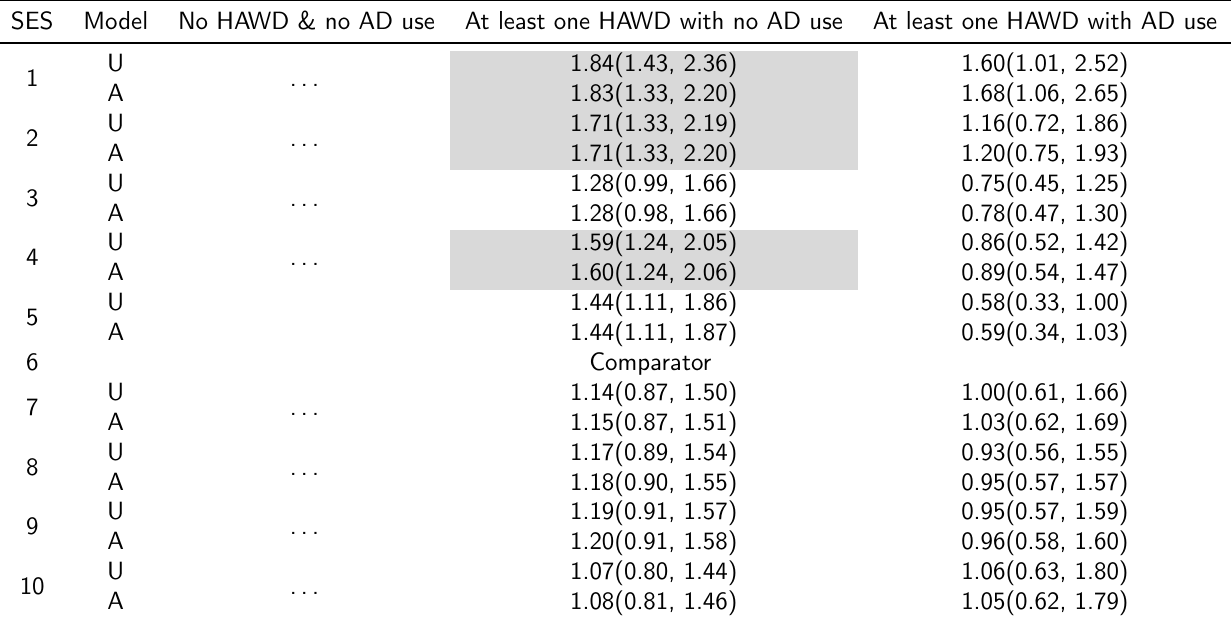
Table 5: Odds (with 95% confidence intervals) of hospitalizations (medical or psychiatric) associated with depression by anti- depressant use over